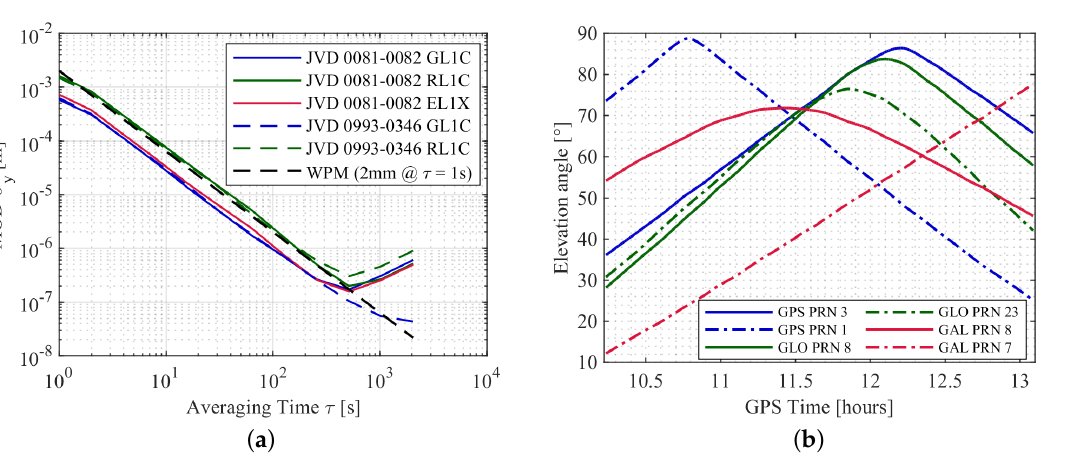
Figure 14. Modified ADEV’s of the L1 carrier phase DDs for one satellite pair of each GNSS system with two different receiver combinations in ( a ), corresponding elevation angles of the satellites in ( b ). Solid and dash-dot lines represent reference and the other satellite in ( b ), respectively.